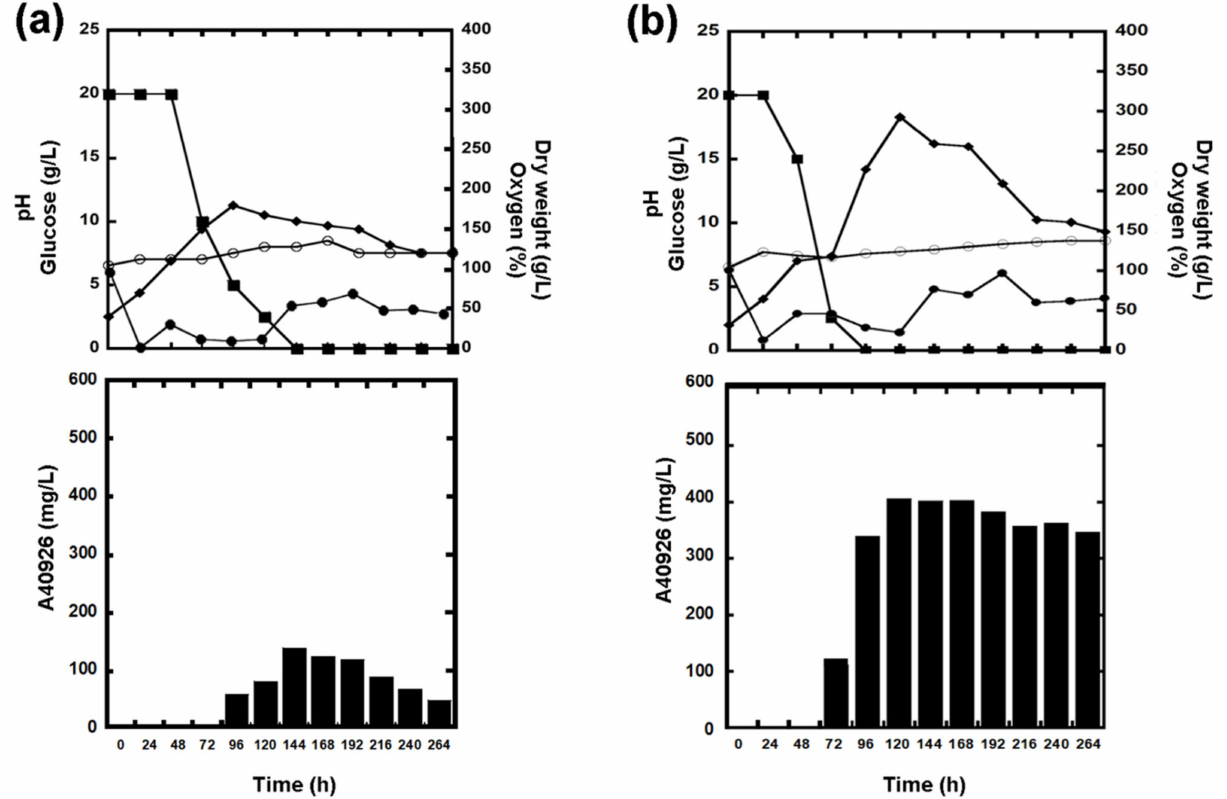
Figure 4. Time courses of N. gerenzanensis ATCC 39727 ( a ) and its more A40926-resistant G variant ( b ) cultivated in FM2 medium at 2 L working-volume bioreactor scale. Glucose consumption (filled rectangles), biomass accumulation (filled rhombi), pH (circles), O 2 level (filled circles), and A40926 production (filled bars) were monitored every 24